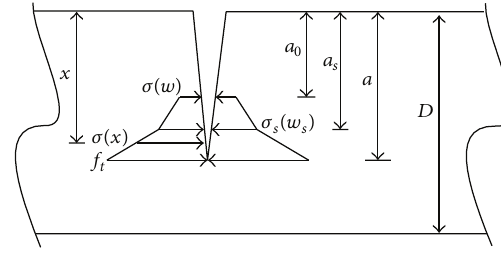
Figure 5: Crack propagation stage III.